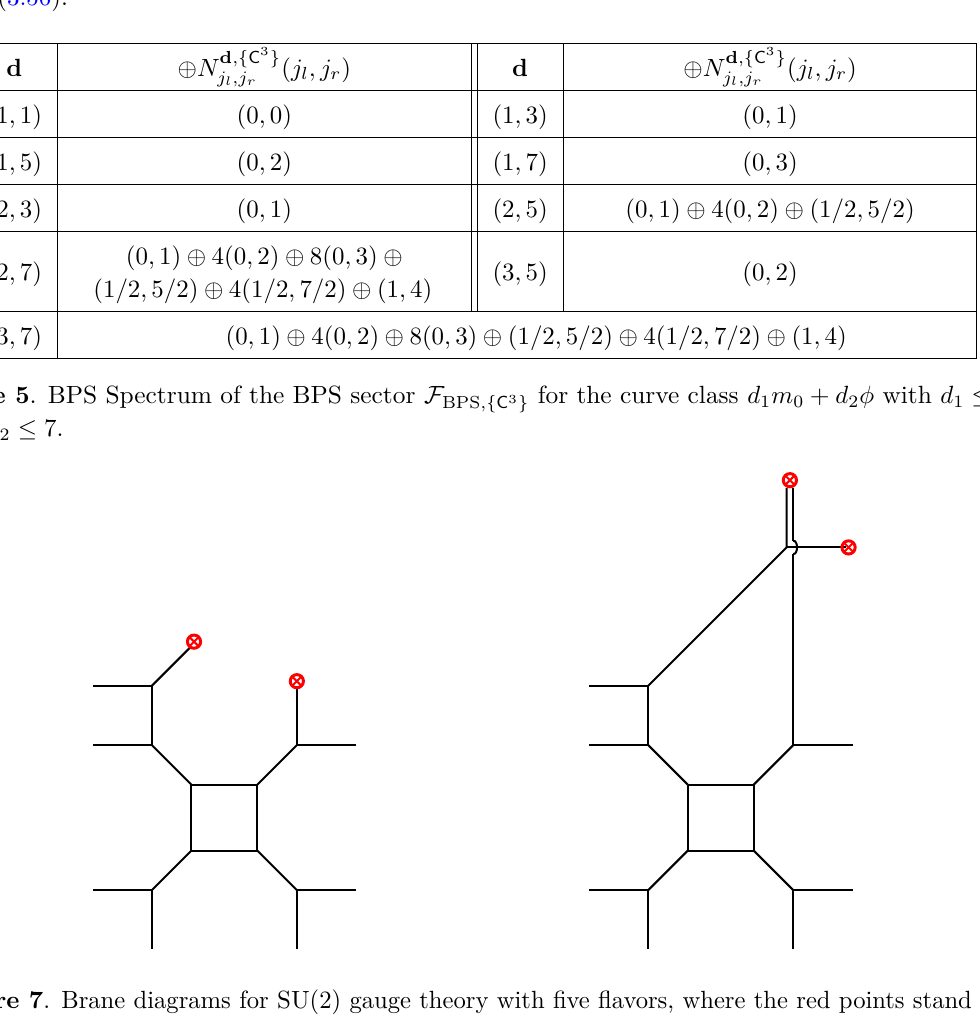
Table 4 . Pseudo-BPS Spectrum of SU(2) Wilson loop expectation value in the representation 2 ⊗ 2 ⊗ 2 for the curve class d 1 m 0 + d 2 φ with d 1 = 1 , 2 , 3 , and d 2 ≤ 5 . The d 1 = 0 part can be read from (3.56).